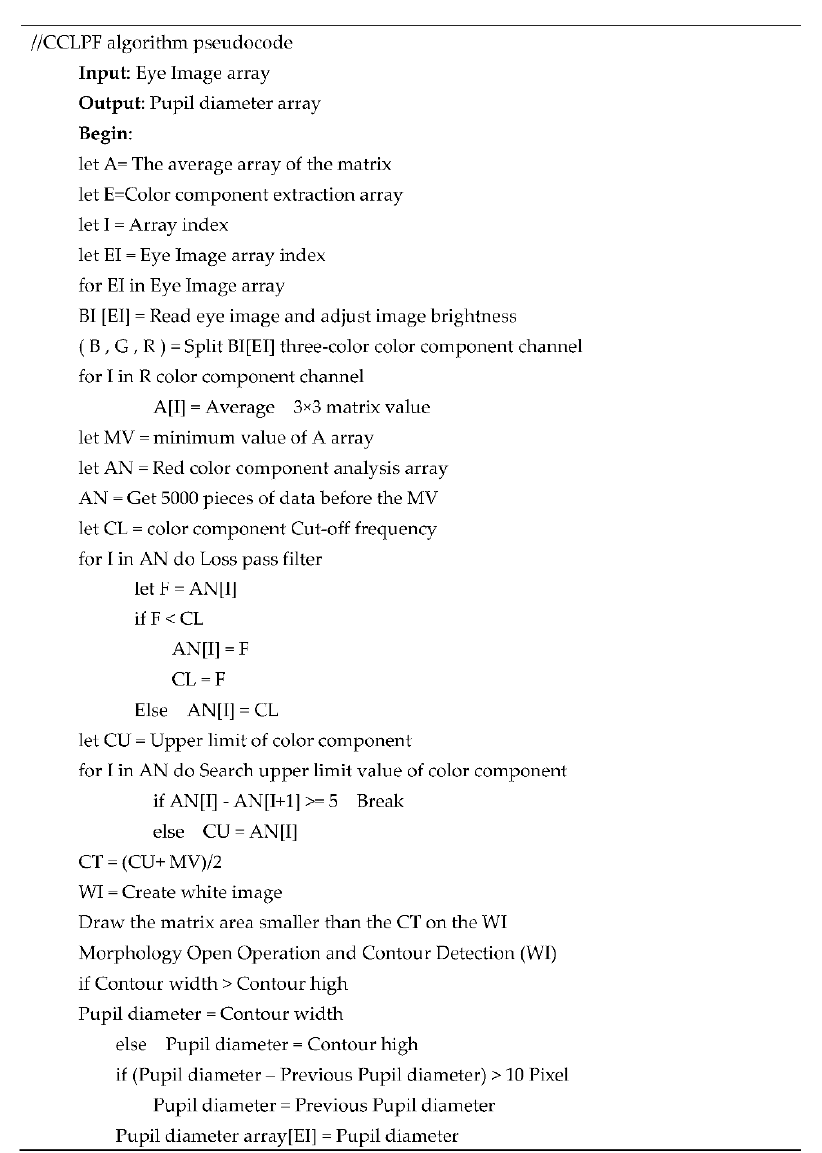
Figure 31. Analysis of inaccurate pupil diameter data for Data Set 4.